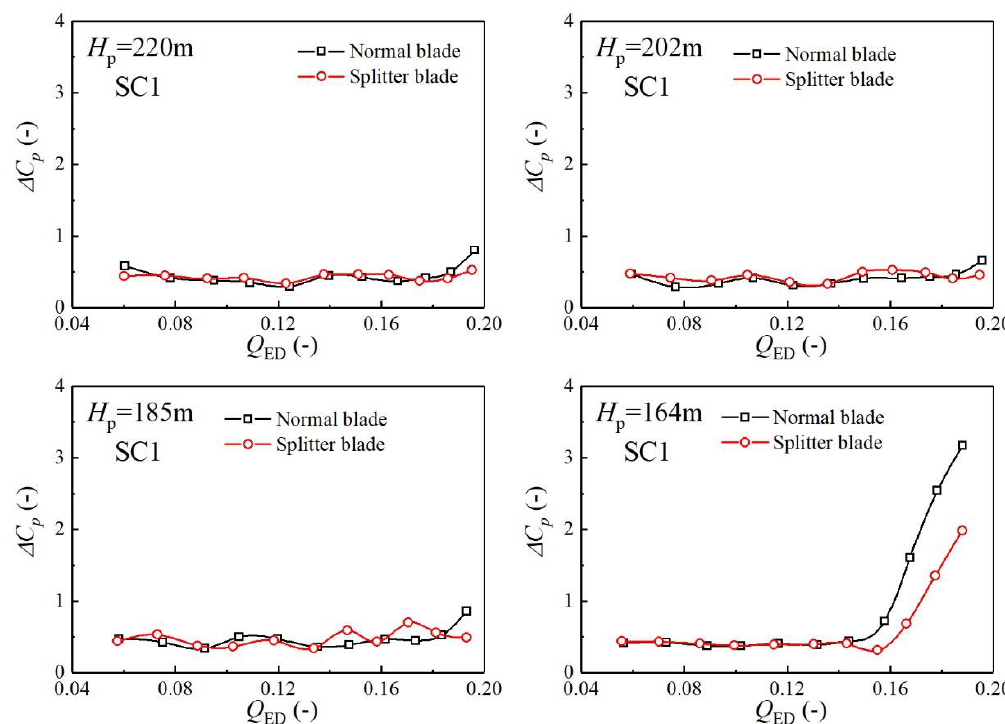
Figure 12. Peak-to-peak values for spiral casing at di ff erent heads.